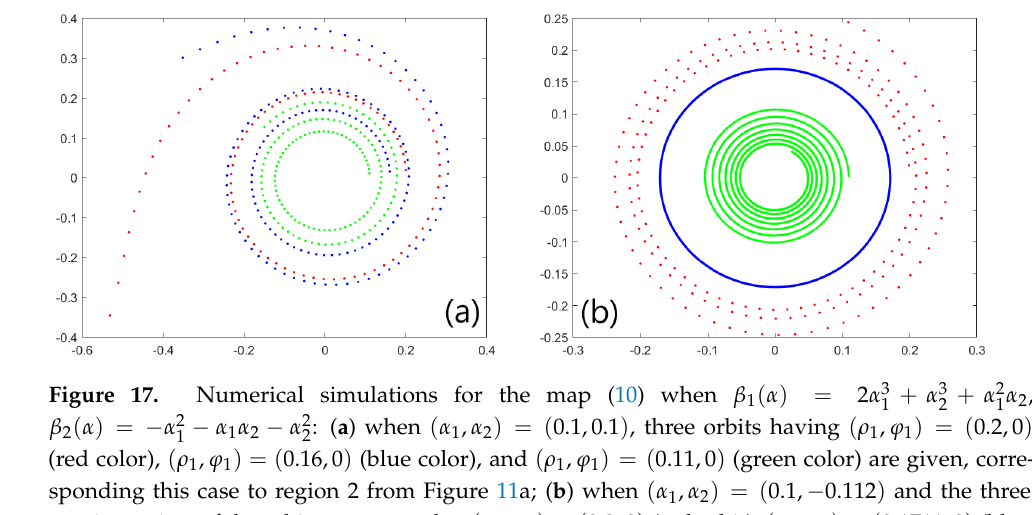
Figure 17. Numerical simulations for the map (10) when β 1 ( α ) = 2 α 3 − α − α 2 β 2 ( α ) = − α 2 : ( a ) when ( α 1 , α 2 ) = ( 0.1,0.1 ) , three orbits having ( ρ 1 , ϕ 1 ) = ( 0.2,0 ) 1 α 2 2 1 (red color), ( ρ 1 , ϕ 1 ) = ( 0.16,0 ) (blue color), and ( ρ 1 , ϕ 1 ) = ( 0.11,0 ) (green color) are given, corre- sponding this case to region 2 from Figure 11a; ( b ) when ( α 1 , α 2 ) = ( 0.1, − 0.112 ) and the three starting points of the orbits correspond to ( ρ 1 , ϕ 1 ) = ( 0.2,0 ) (red orbit), ( ρ 1 , ϕ 1 ) = ( 0.1711,0 ) (blue orbit), ( ρ 1 , ϕ 1 ) = ( 0.11,0 ) , (green orbit), respectively, we obtain the phase portrait corresponding to region 1 from Figure